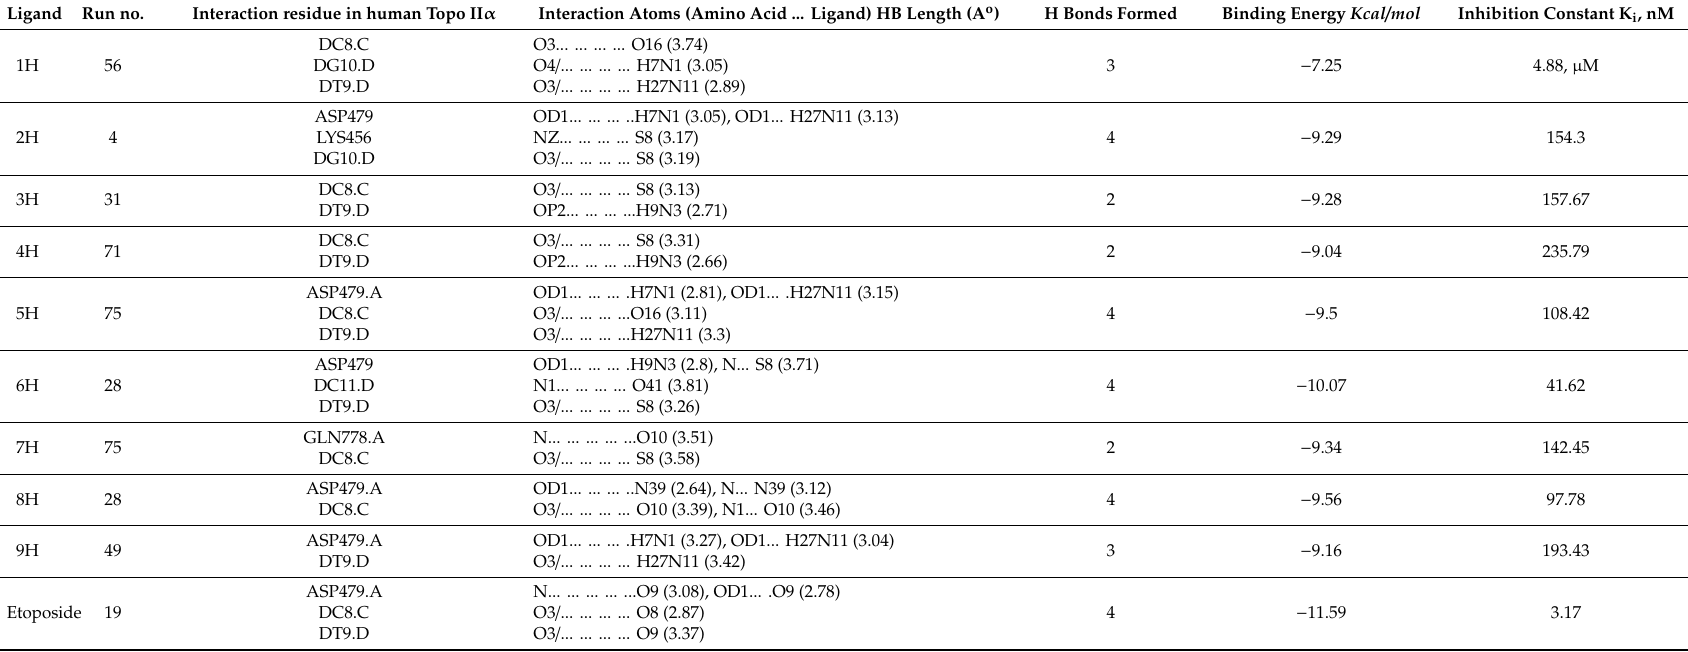
Table 7. Molecular interactions of the nine derivatives of TUDHIPP (1H–9H) with human DNA topoisomerase II β (3qx3). Ligand Run